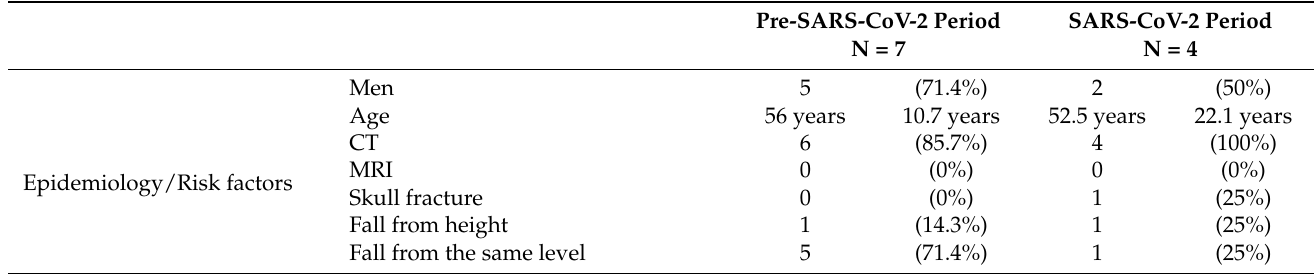
Table 2. Epidemiology and management of patients with moderate